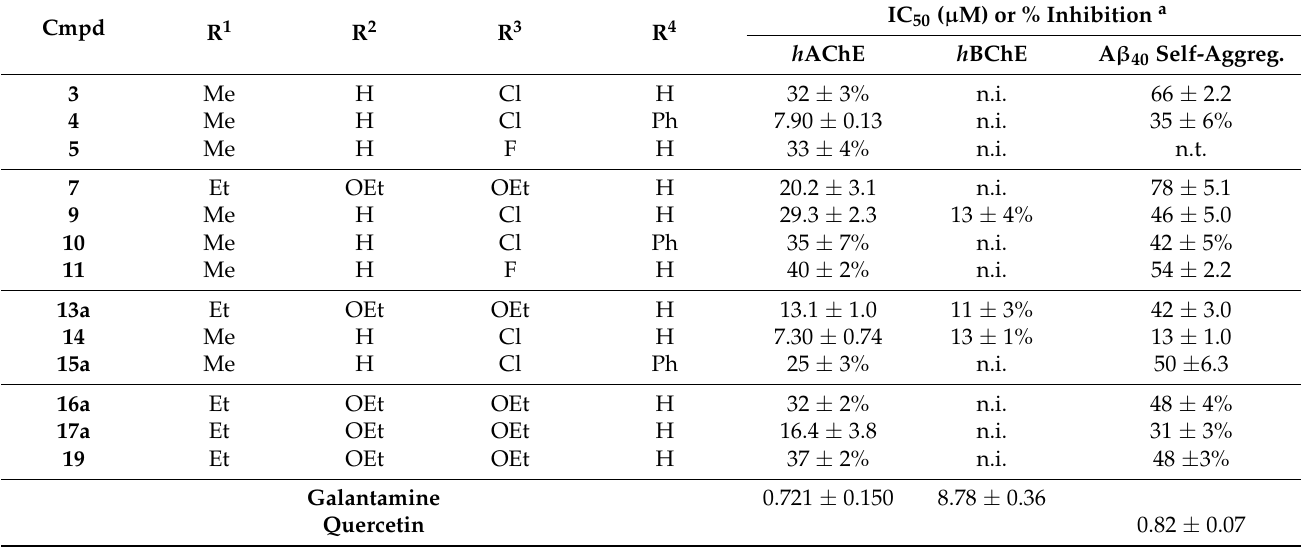
Table 2. Inhibitory activity on human acetylcholinesterase (AChE) and butyrylcholinesterase (BChE) and self-induced β -amyloid (A β ) aggregation by representative DHPPIQ derivatives.